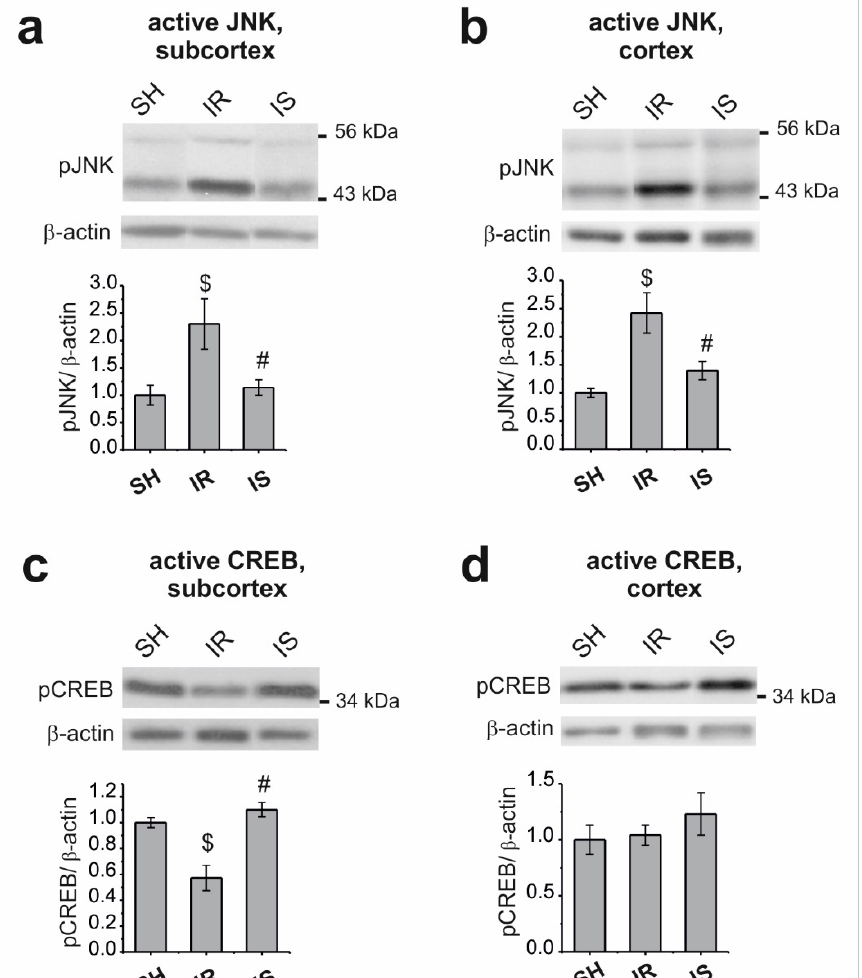
Figure 2. Analysis of changes in the level of the pJNK and pCREB proteins during ischemia and Semax treatment in the subcortical structures and frontoparietal cortex of rats at 24 h after tMCAO. Immunoblot of pJNK ( a , b ) and pCREB ( c , d ) content in the subcortex and cortex. The upper part of the figures shows a typical immunoblot for each group. The histograms report the relative protein content in the group, which was normalized to that of β -actin; the protein content in the SH group is taken as “1”. Statistical significance is indicated above the bars as $ p < 0.05 and # p < 0.05, IR versus SH and IS versus IR, respectively. The data are presented as the mean ± standard error of the mean (S.E.M.) (n = 5–7 animals per